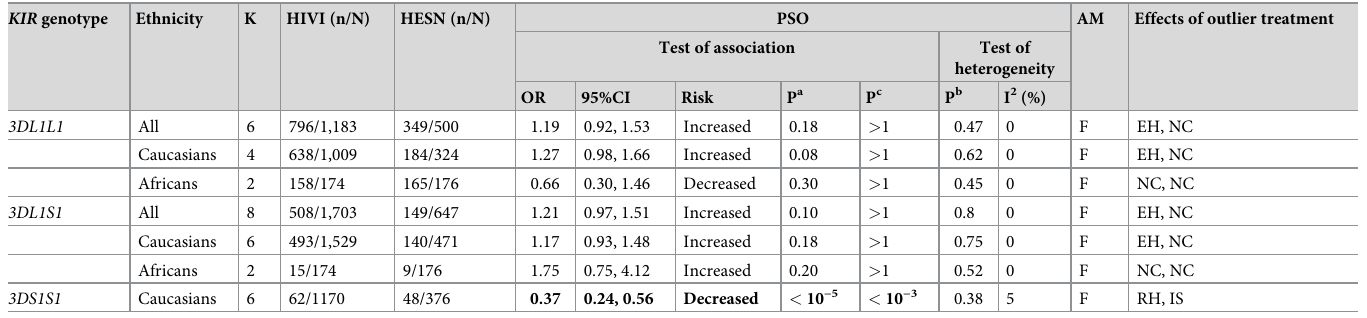
PSO: post-outlier; K: number of studies; HIV: Human Immunodeficiency Virus; HIVI: HIV-Infected; HESN: HIV-exposed seronegative ; n: number of individuals; N: total number; OR: odds ratio; CI: confidence interval; P a : P-value for test of association; P c : Bonferroni correction for P a ; P b : P-value for heterogeneity; I 2 is a measure of indicate significant associations